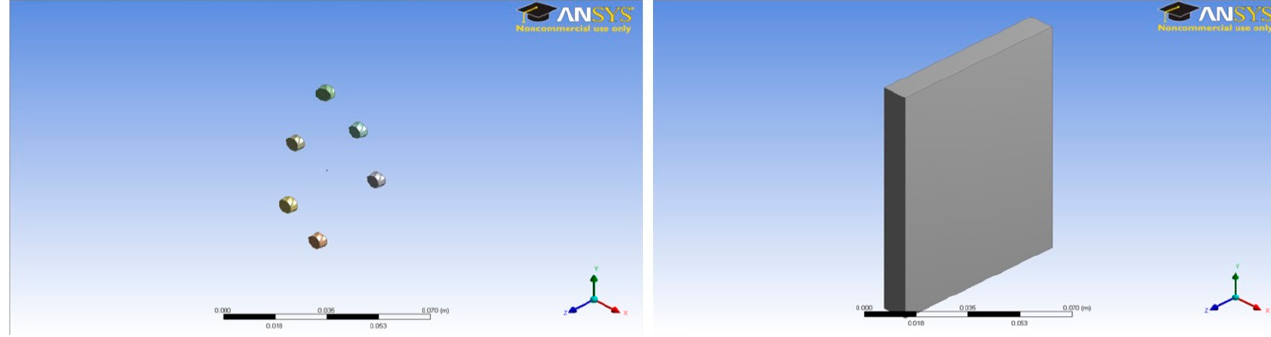
Figure 8. Three percent coarse aggregate sample model (11 × 7 × 1 cm) and concrete